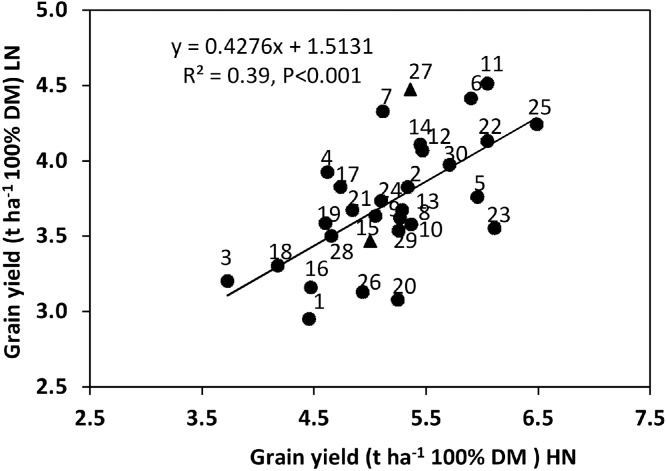
Grain yield of 30 wheat cultivars (codes 1–30, see Table 1 for cultivar names) in high (HN) and low N (LN) treatment. Values represent means of 2013-14 and 2015-16. DF = 174, SED Genotype 0.305***; N × Genotype 0.453* (bread wheat cultivars ●; durum wheat cultivars ▲).